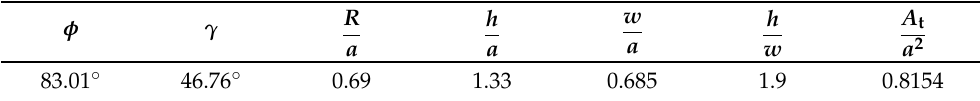
Table 1. Numerical solution for the geometry with the maximum cross-sectional area A t . φ